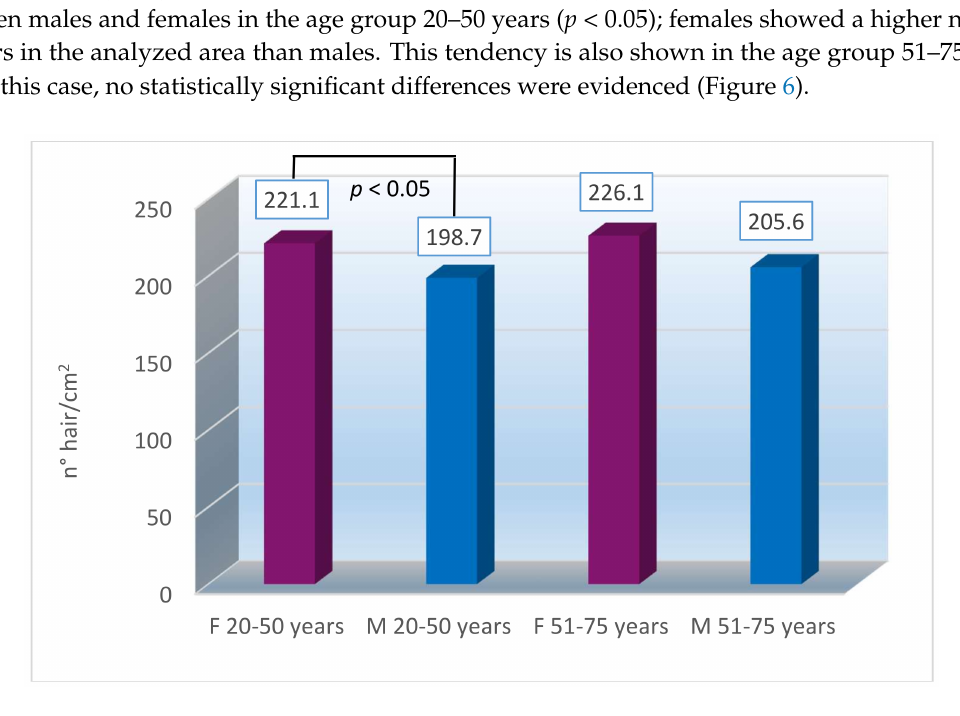
Figure 6. Mean basal values of hair density as a function of the age group and